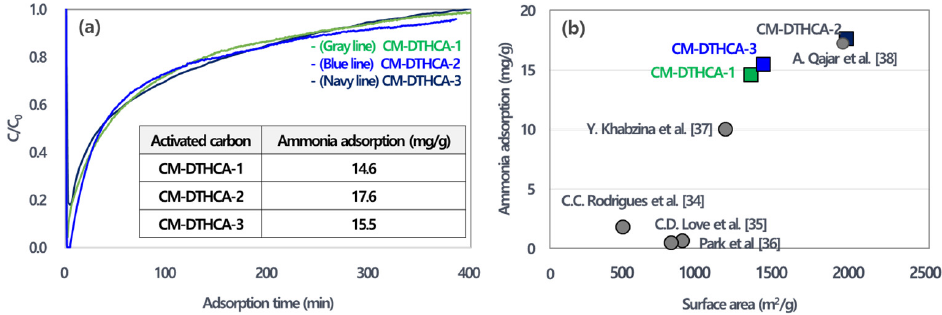
Figure 10. ( a ) Breakthrough curve of CM-DTHCAs (Co = 800 ppm; M = 1.0 g and N 2 = 2 L/min) and ( b ) relationship between surface area and ammonia adsorption of this research and previous research [34–38].